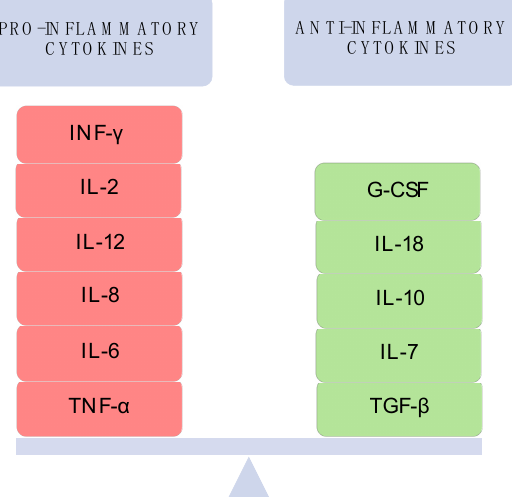
Figure 2. Cytokines in breast milk. (Modified from Kielbasa et al., 2021.)